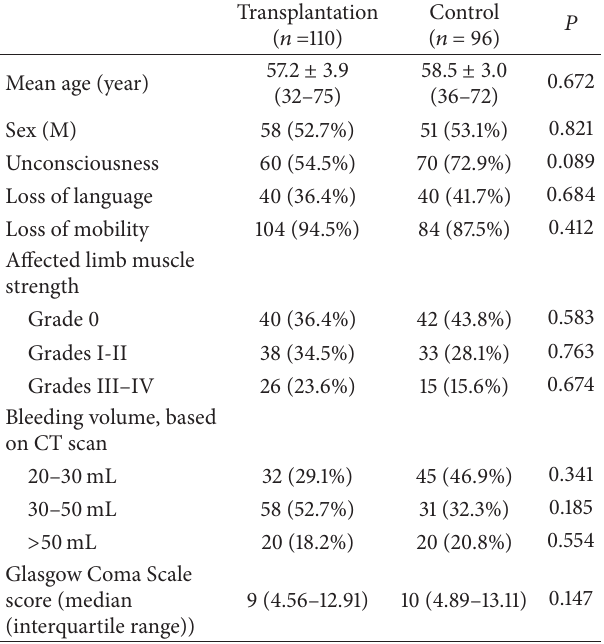
Table 1: Demographic data of patients in transplantation and control groups.